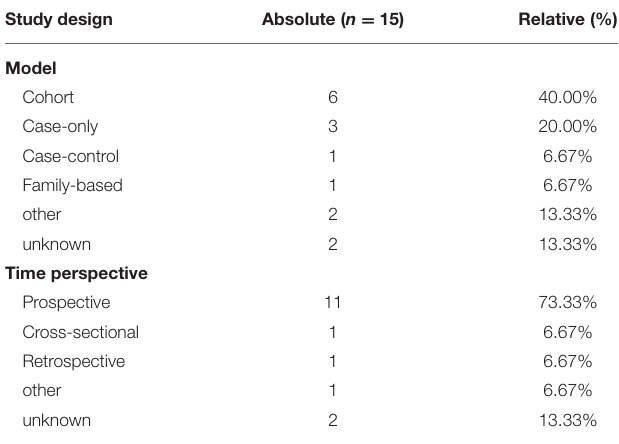
TABLE 6 | Study design of observational